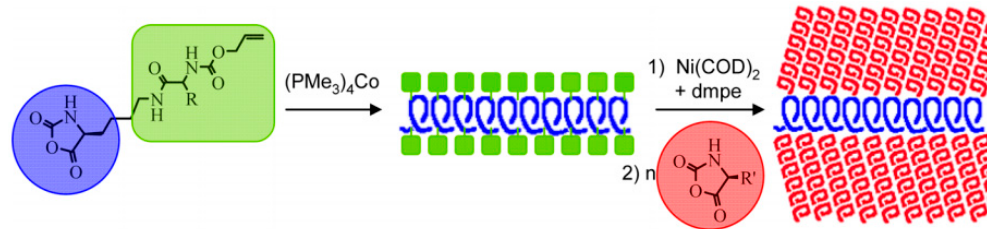
Figure 48. One-pot synthesis of cylindrical brush copolypeptides reported by Deming et al. The N -carboxyanhydride (NCA) component (blue) of N ε -(alloc- L -methionyl)- L -lysine NCA was first polymerized using (PMe 3 ) 4 Co initiator to give a linear polypeptide that bears pendant initiator precursors (green). Side-chain initiators were then activated by using dmpeNi(COD), followed by addition of a second NCA monomer (red) to give the brush copolymers. Reproduced with permission from reference [218].